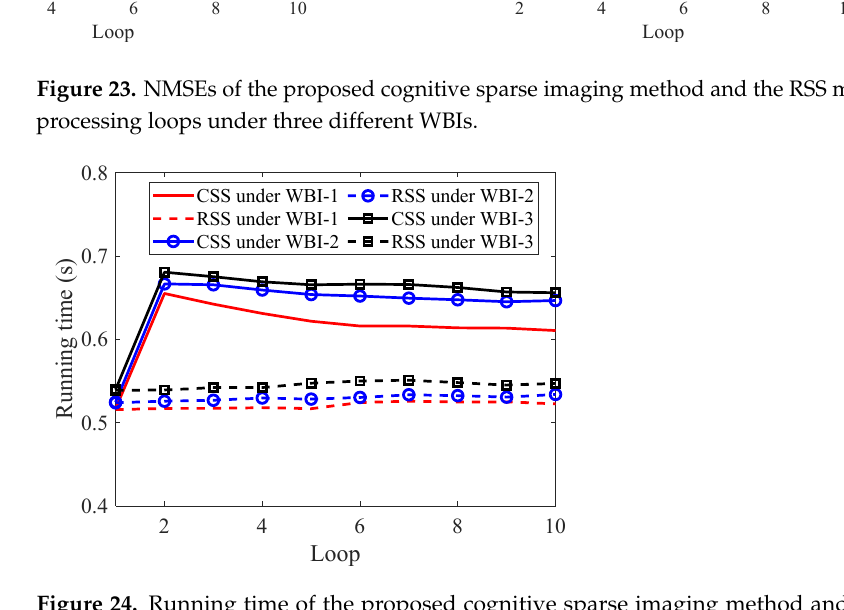
Figure 24. Running time of the proposed cognitive sparse imaging method and the RSS method against the processing loops under three different WBIs. Table 2. Running time of different processing steps of the proposed method at different loops un-